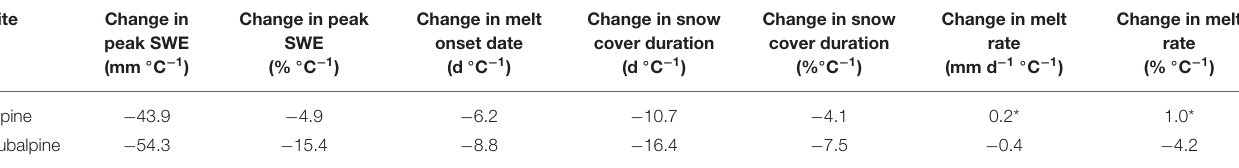
TABLE 3 | Changes to mean snow accumulation and melt metrics associated with the baseline (WY1991–WY2013) and climate warming scenarios. Site